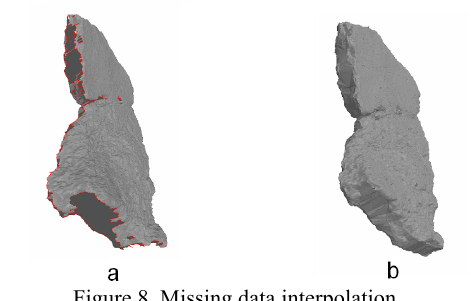
Figure 8. Missing data